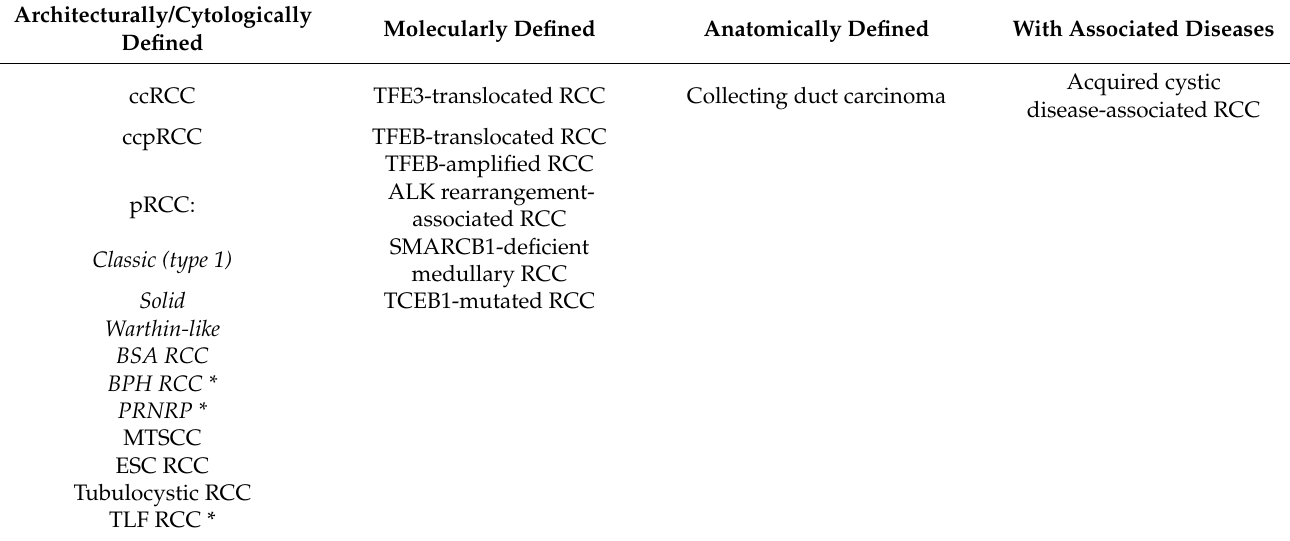
Table 4. Simplified overview of the organization of categories of renal cell tumors with papillary growth.